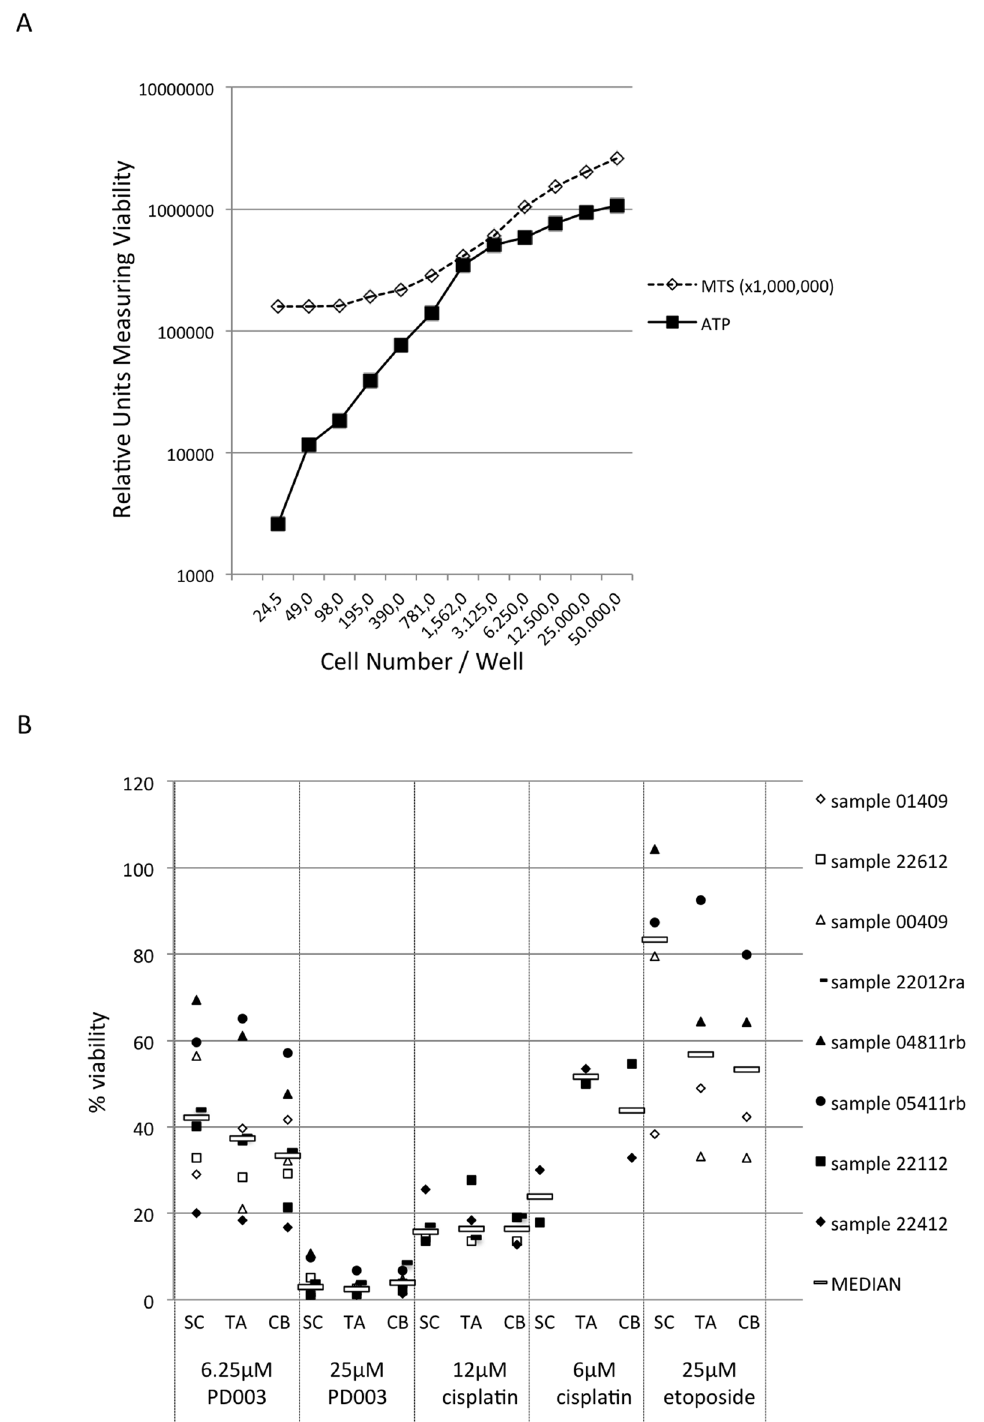
Figure 4. Anti-growth effect of the Pd complex on cancer stem cells (CSC). (A) MTS assay and ATP assay were compared to assess anti- growth effect using small cells numbers. (B) Anti-growth effect was measured by the ATP assay using SCs, TA cells and CB cells derived from three patients with benign prostate hyperplasia (white-filled shapes) and five patients with prostate carcinoma (black-filled shapes). White bar represents the median value of all the samples.